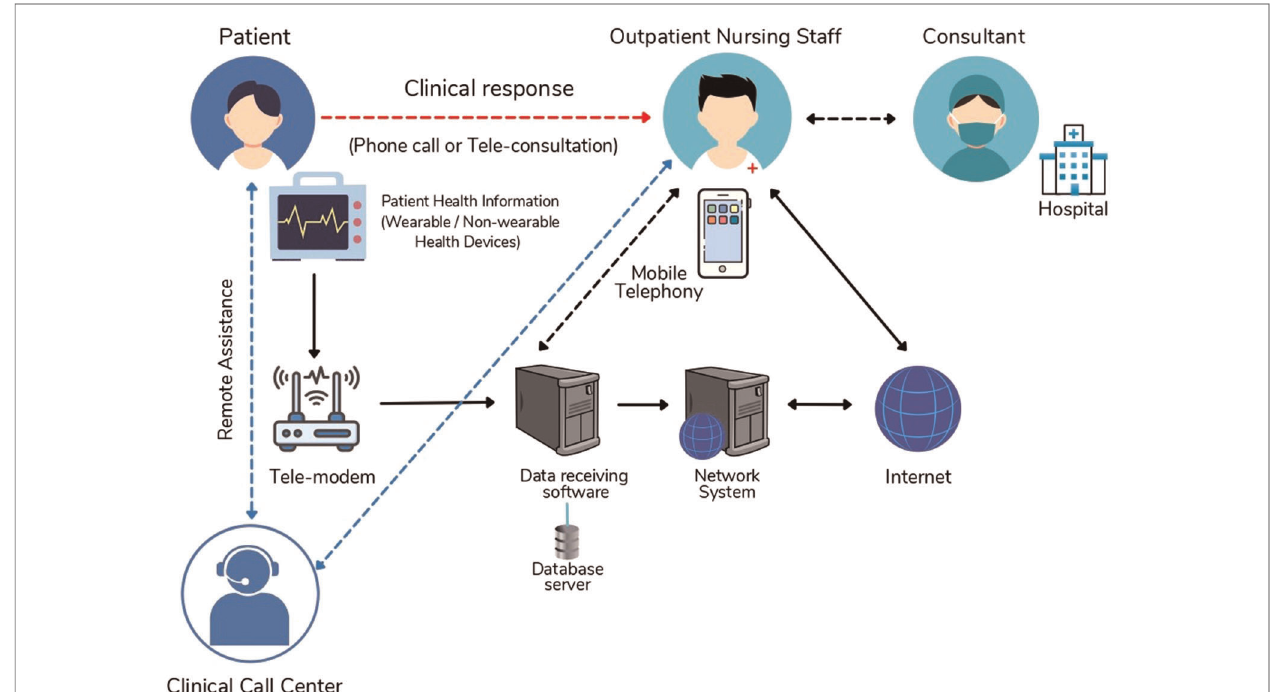
FIGURE 1 | Network architecture of telehealth